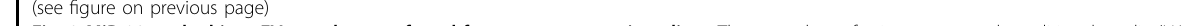
the neuronal EVs and miR-98, respectively. pAAV-SYN- MCS-EYFP-3FLAG was used as control label (Fig. 3a).